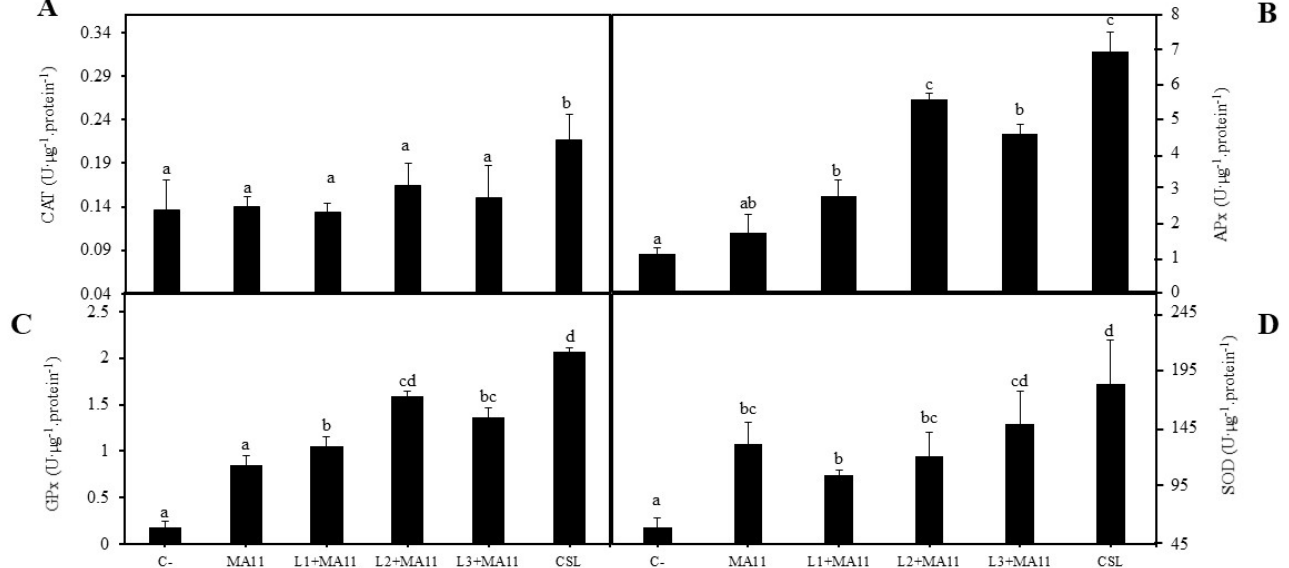
Figure 5. Level of antioxidant activities. ( A ) Catalase, ( B ) ascorbate peroxidase, ( C ) guaiacol peroxidase, ( D ) superoxide dismutase activities in leaves of M. sativa 60 days after germination under greenhouse conditions with a nutrient-poor soil as substrate and different inoculation treatments. Values are mean ± S.D. ( n = 16). Different letters indicate means that are significantly different from each other (one-way ANOVA; LSD test, p < 0.001). C-: without inoculation; MA11: inoculation with strain MA11; L1+MA11: inoculation with strains L1 and MA11; L2+MA1: inoculation with strains L2 and MA11; L3+MA11: inoculation with strains L3 and MA11; CSL: inoculation with a consortium of strains L1, L2, L3, and MA11.